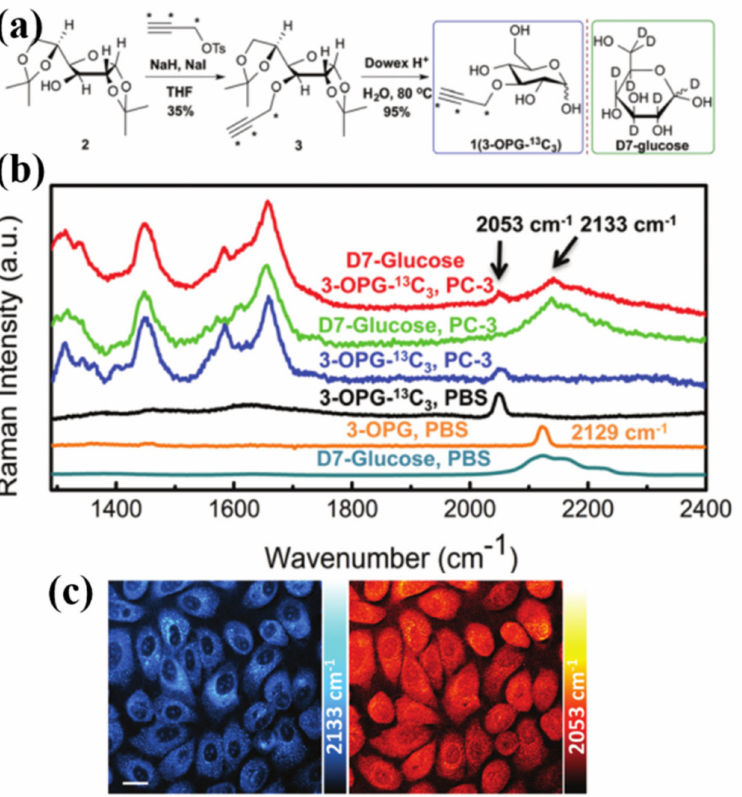
Figure 12. ( a ) The editing and synthesis process of 3-OPG- 13 C 3 and the structure of D7-glucose. ( b ) Raman spectra of different types of glucose probes in PC-3 and PBS solutions. ( c ) Two-color SRS imaging of PC-3 cells using 3-OPG- 13 C 3 and D7-glucose probes at 2133 cm − 1 and 2053 cm − 1 , respec- tively [57]. Republished with permission from Ref. [57]. Copyright 2022 Royal Society of